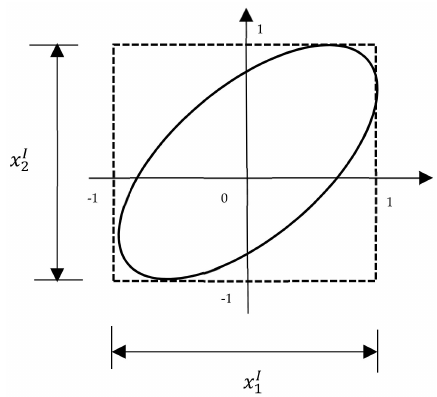
Figure 6. The standardized two-dimensional interaction model.